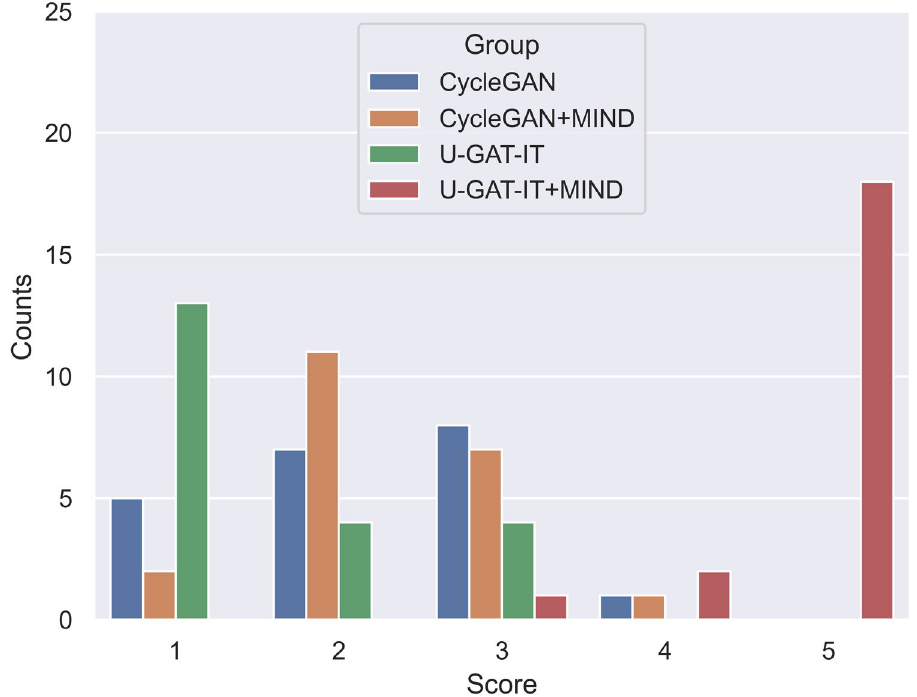
Figure 7. Distribution of evaluation scores for four groups by Dr. A.